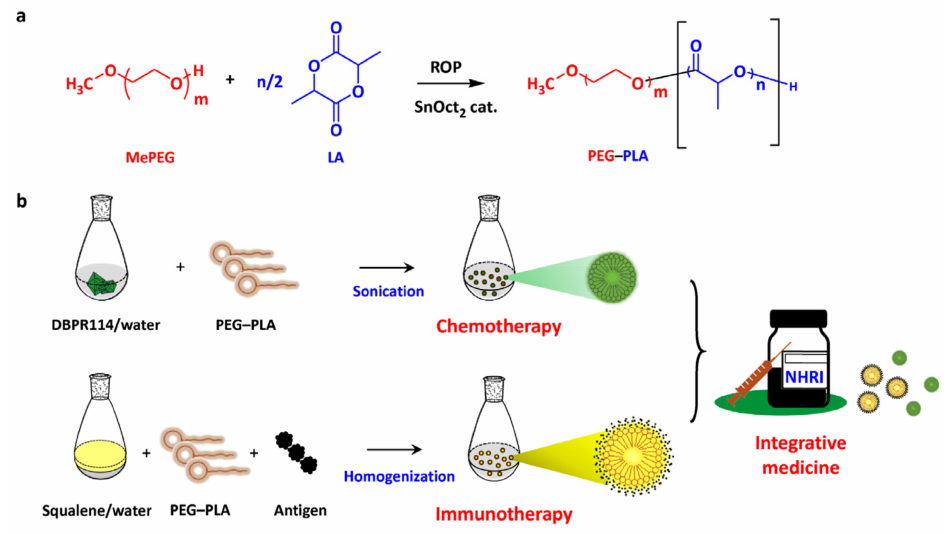
Figure 1. Colloidal assemblies comprised of polymeric micellar/emulsified systems integrate cancer therapy combining a tumor-associated antigen vaccine and chemotherapeutic regimens. ( a ) Synthetic pathway of amphiphilic PEG–PLA copolymer. ( b ) Schematic illustration of PEG–PLA-based colloidal assemblies as a co-delivery system of a tumor-associated antigen and a chemotherapeutic drug. The PEG–PLA polymeric micellar solution was first prepared to serve as a dispersing system for the poorly water-soluble drug, DBPR114. In parallel, polymeric micellar solution mixed with squalene was passed through a homogenizer, rendering a uniform emulsion stock. A mixture of tumor- associated antigens, squalene emulsion and micellar DBPR114 solution can be prepared to treat tumor-bearing